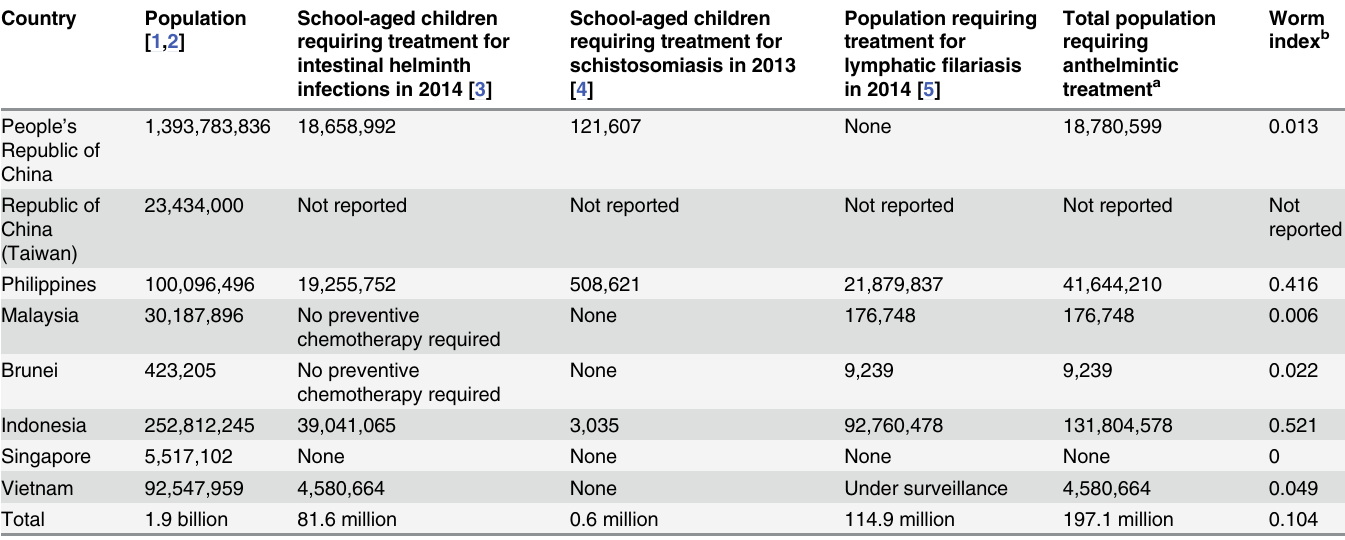
Table 1. Parasitic helminth infections in the eight nations surrounding the South China Sea.